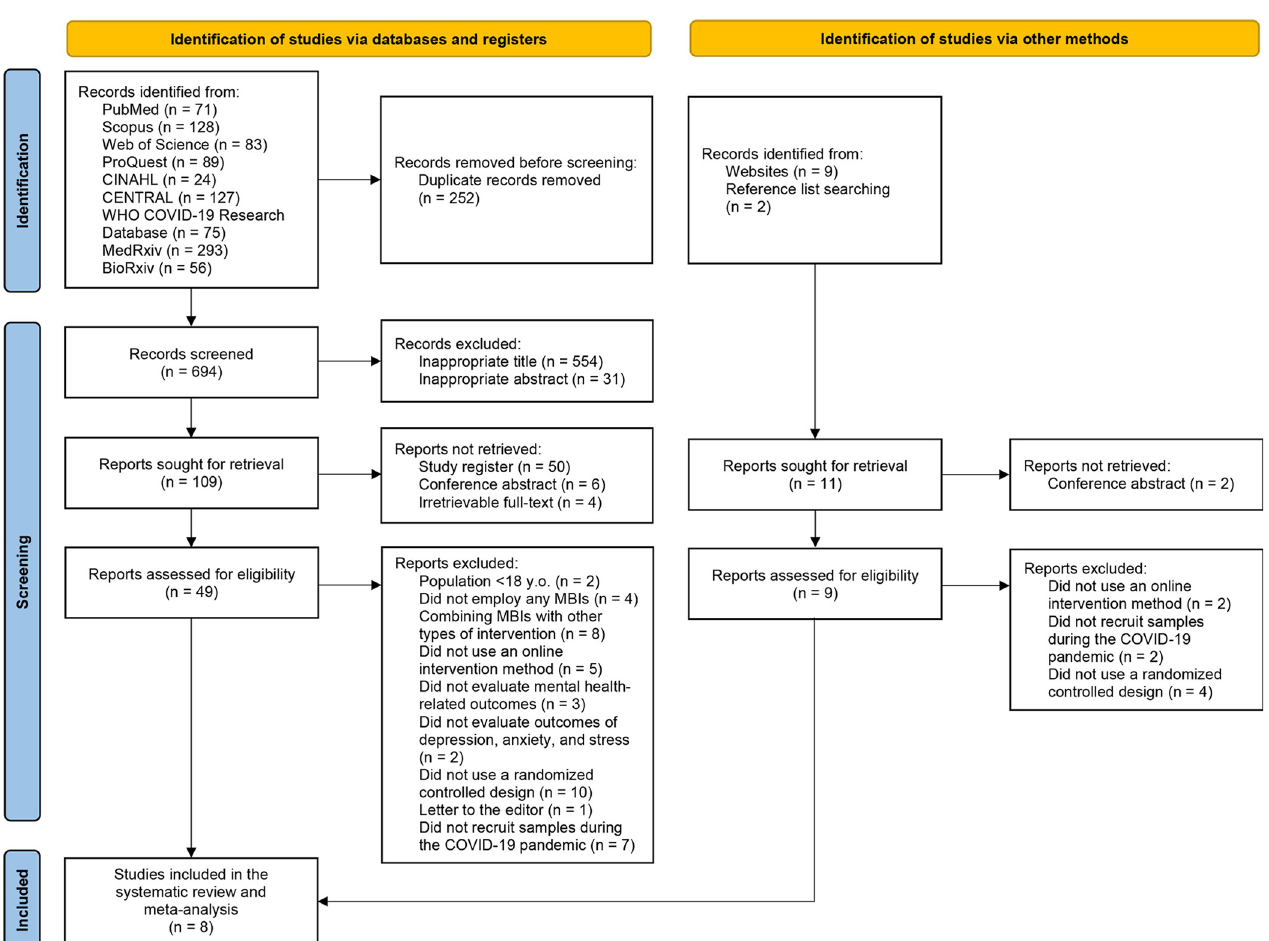
Fig 1. PRISMA flow diagram of the study selection process. CENTRAL , Cochrane Central Register of Controlled Trials; CINAHL , Cumulative Index to Nursing and Allied Health Literature; COVID-19 , Coronavirus Disease 2019; WHO , World Health Organization.